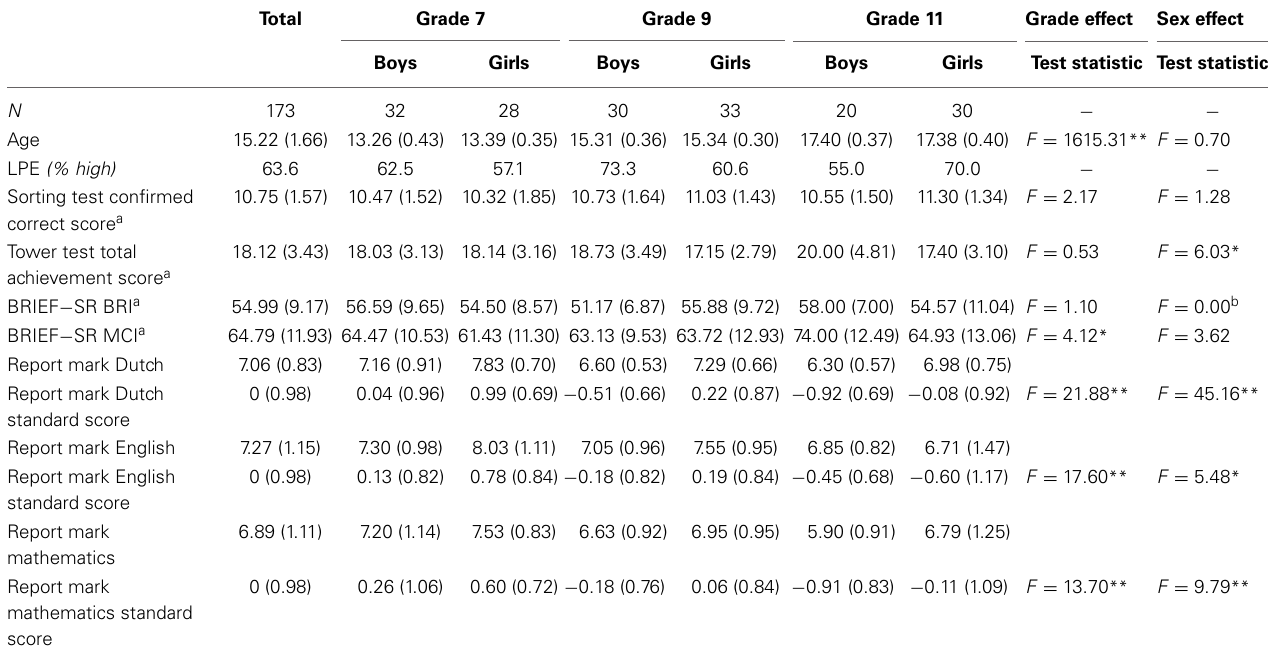
Table 1 | Descriptive statistics of executive function measures and school performance, per grade and sex.